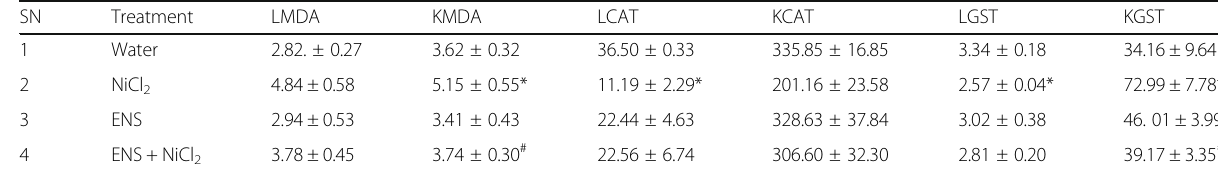
* Significantly different from control # Significantly different from NiCl 2 -treated rats Key: LMDA Liver Malonaldehyde (nmol/min/mg liver weight) KMDA Kidney Malonaldehyde (nmol/min/mg kidney weight)